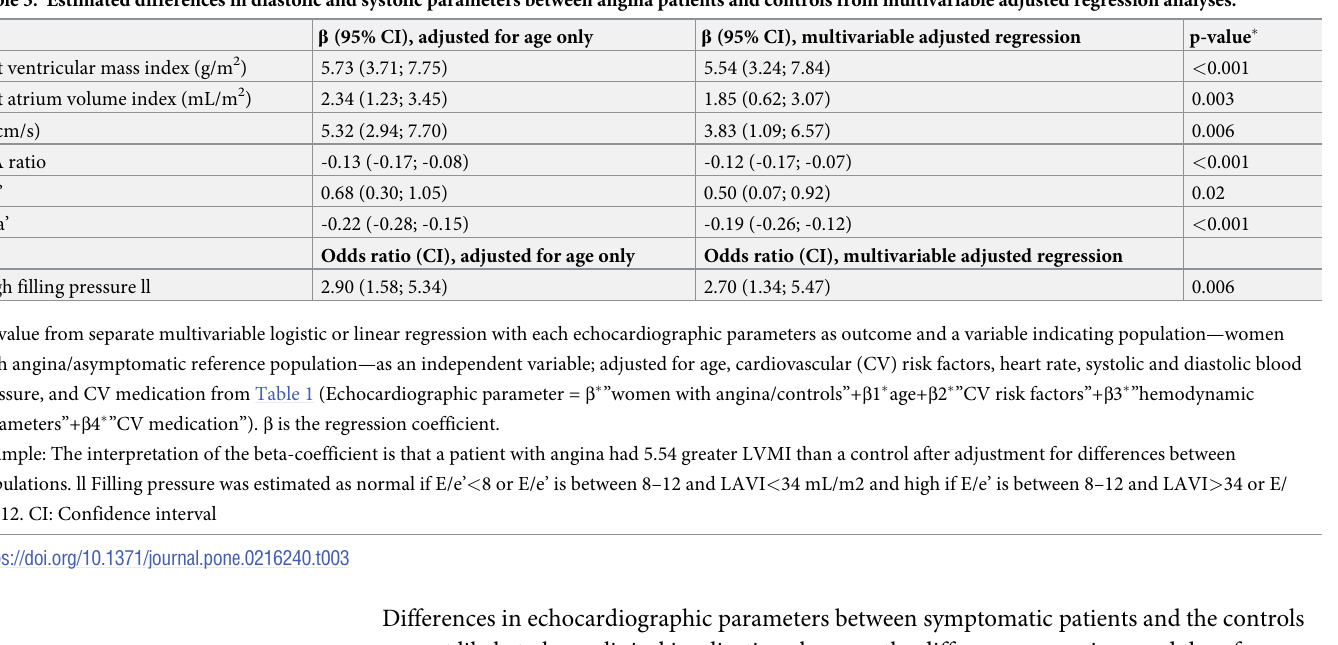
Differences in echocardiographic parameters between symptomatic patients and the controls are not likely to have clinical implications because the differences are minor and therefore can- left undiagnosed since we do not know the pathophysiology behind their symptoms. This a reference population. Typical angina symptoms or burden of symptoms could not indicate which patients had high filling pressure estimated by echocardiography. However, symptoms